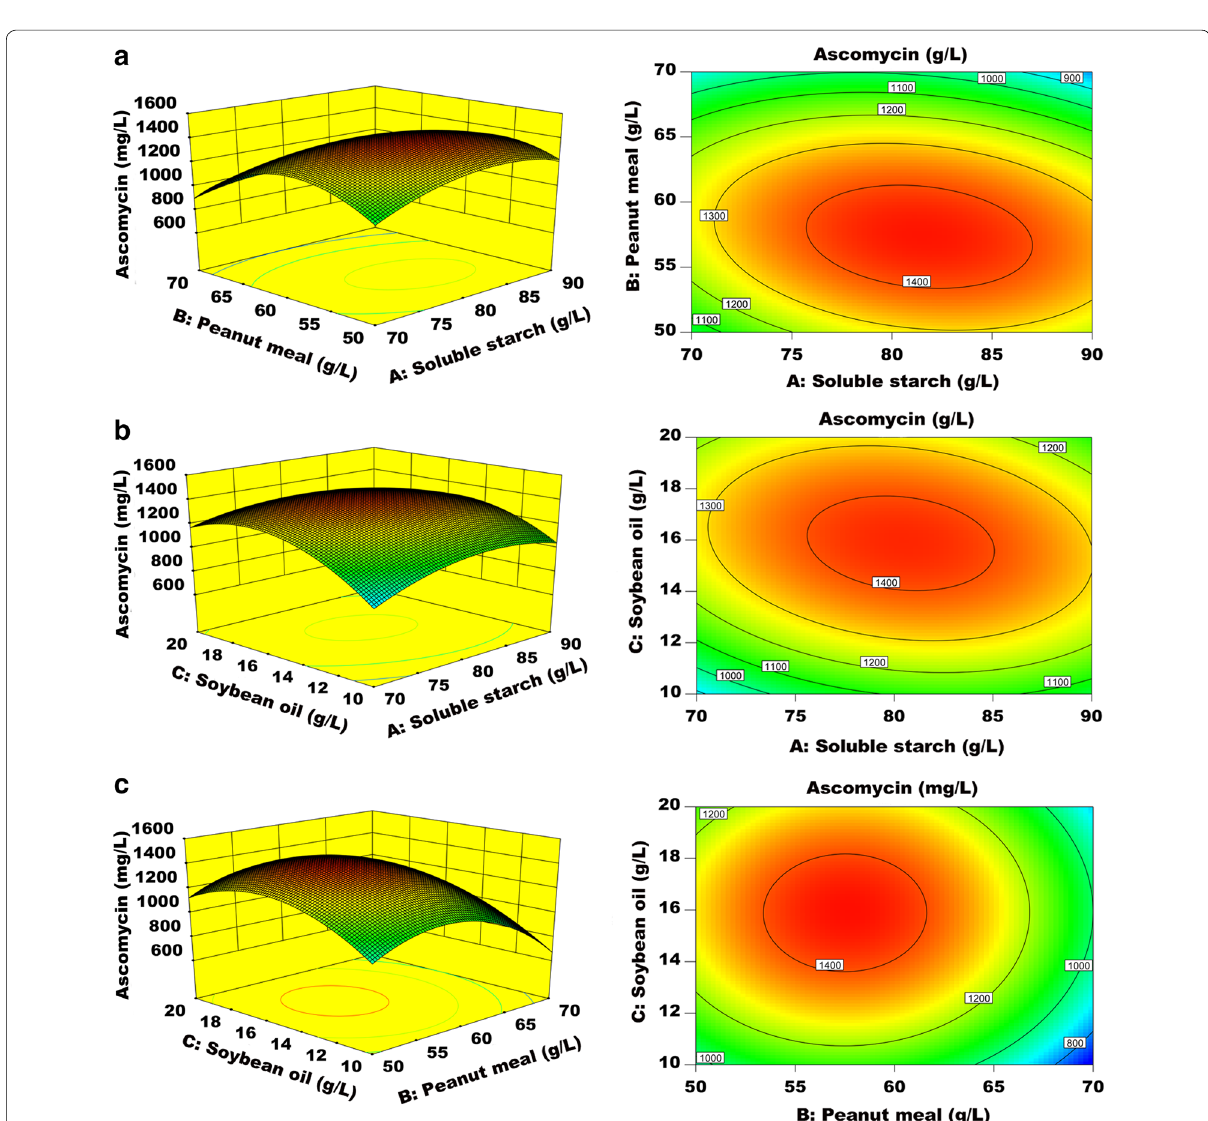
Fig. 4 The effect of mutual interactions among soluble starch,peanut meal and soybean oil on ascomycin production by S. hygroscopicus SKF-36. Response surfaces and contour plots of effects of interactions between soluble starch and peanut meal ( a ), soluble starch and soybean oil ( b ), peanut meal and soybean oil ( c ) on ascomycin production by